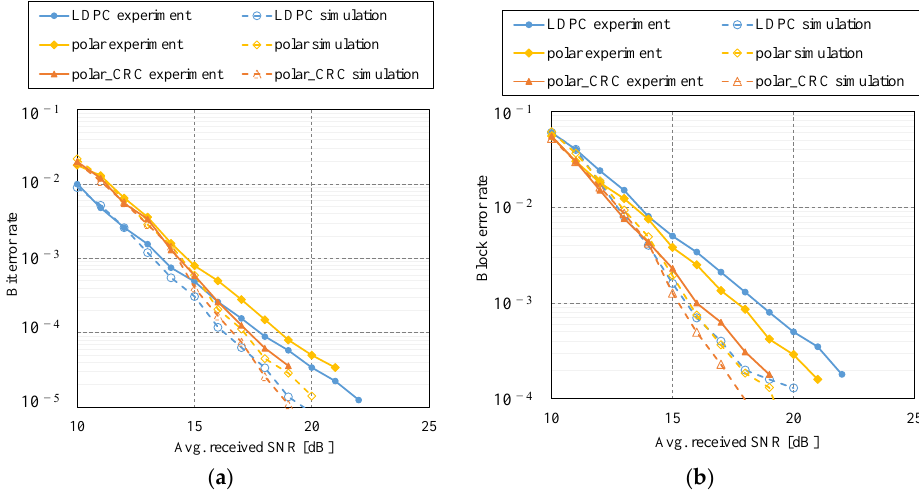
Figure 8. Performance comparison of experiment (solid lines) and simulation results (dashed lines): ( a ) BER and ( b ) BLER. BLER performance for experimental result is the same as shown in Figure 7.